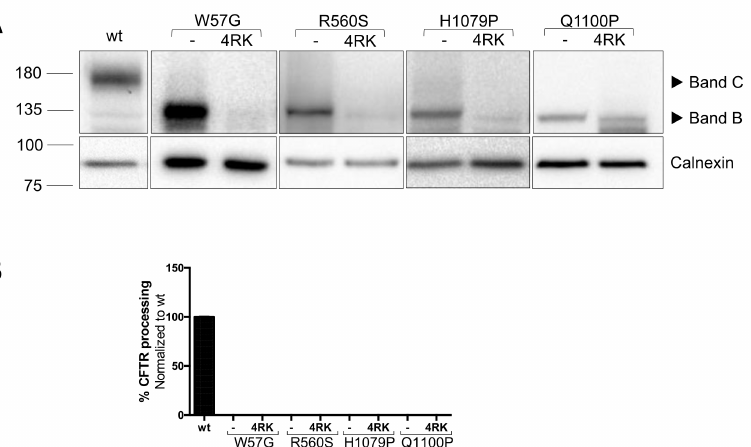
Figure 4. Assessment of the CFTR processing in HEK 293T cells transiently expressing W57G-, R560S-, H1079P- and Q1100P- CFTR alone or in cis with 4RK. ( A ) Representative WB analysis of HEK 293T cells transiently expressing W57G-, R560S-, H1079P- and Q1100P-CFTR alone and in cis with 4RK. ( B ) Densitometry was used to calculate the percentage of mature CFTR (Band C/Band B + Band C). Images were acquired using ChemiDoc XRS+ imaging system BIO-RAD and processed using Image lab 6.0.1